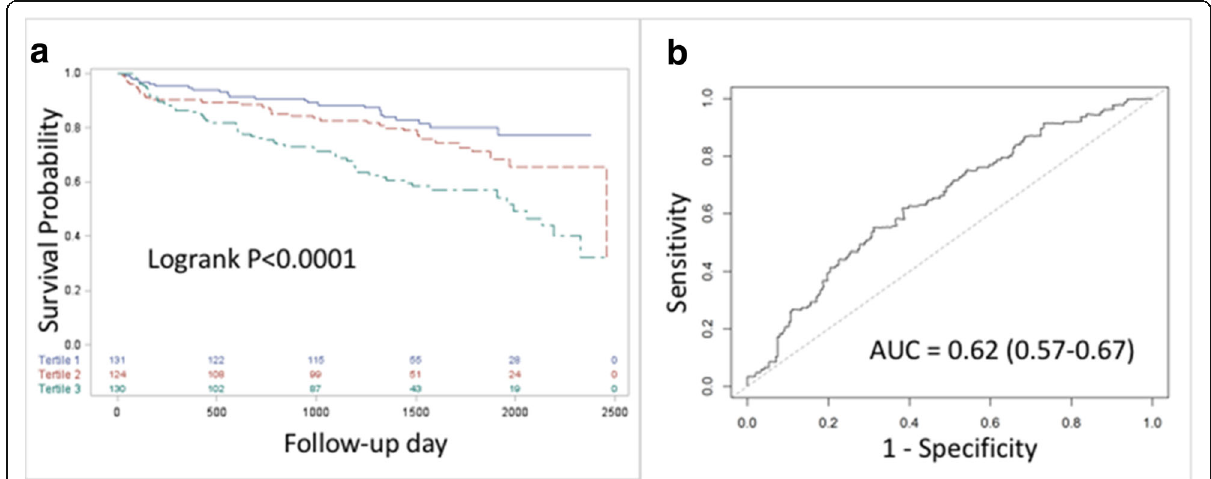
Fig. 1 Internal validation of the risk score. a Comparison of survival curves based on risk score tertiles (blue = bottom tertile; red = middle tertile; green = top tertile), internal validation. b Receiver operator characteristic (ROC) curve, internal validation